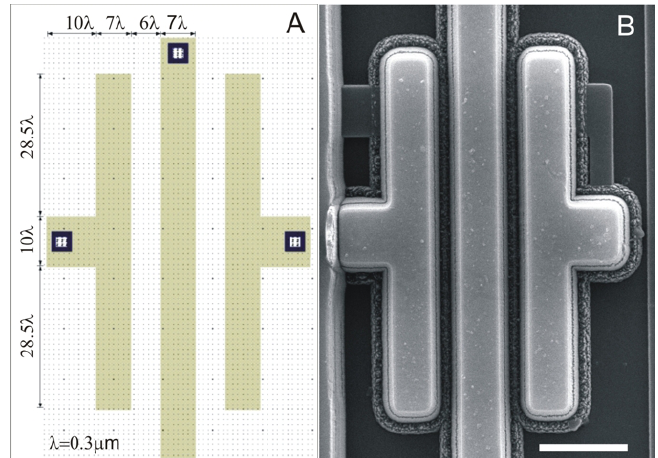
electrodes. The gap between the electrodes is 1.3  m. Scale bar: 10 